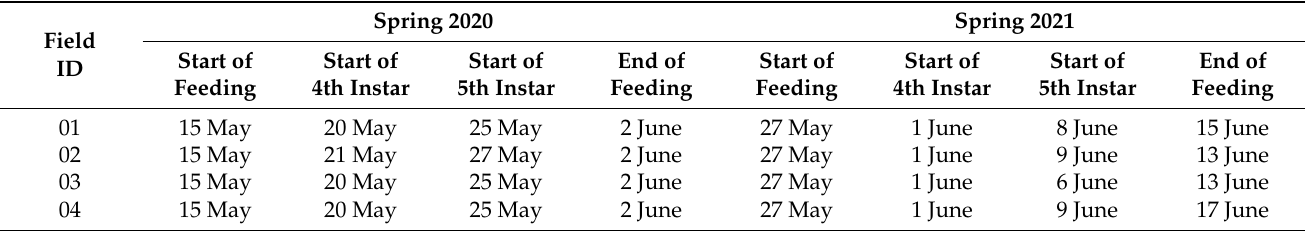
Table 1. Dates when PlanetScope images of each field were downloaded in relationship with each rearing